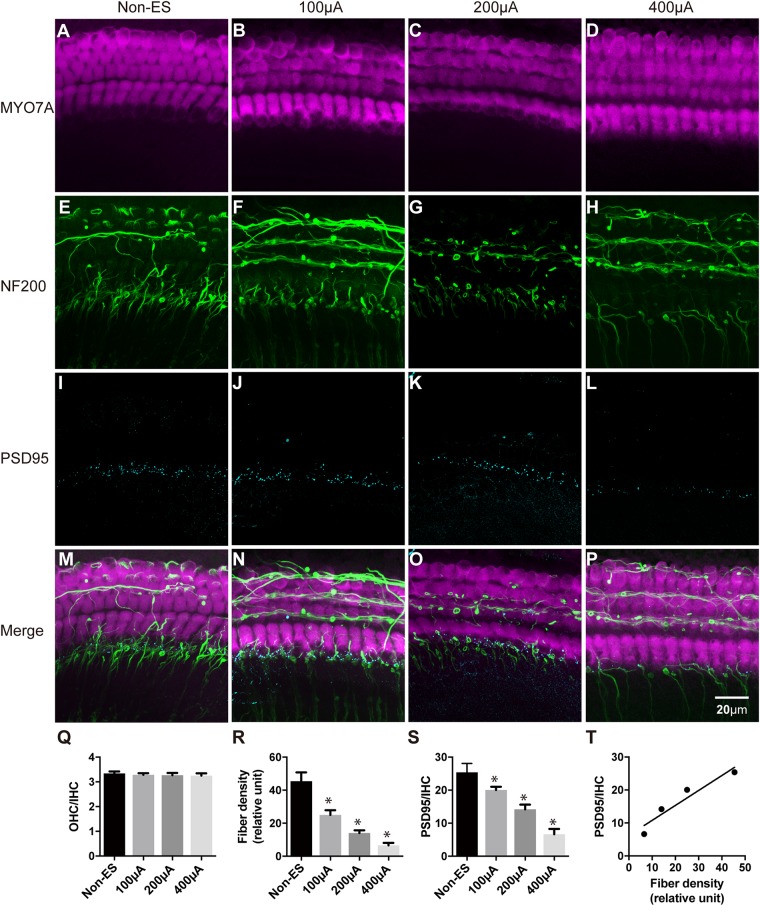
The density of SGN peripheral fibers and the quantity of IHC synapses were synchronously decreased with increasing ES intensity. The quantity and morphology of hair cells (in magenta) were comparable in explants treated with non-ES, 100 μA ES, 200 μA ES or 400 μA ES for 48 h (A–D; P = 0.6957, P = 0.5289, P = 0.3364, compared with non-ES in panel Q, one-way ANOVA followed by Dunnett’s multiple comparisons test, the following comparisons in this paper used the same method unless otherwise noted, n = 5 in each group). The density of SGN peripheral fibers (in green) in explants treated with 100, 200, and 400 μA ES for 48 h was significantly less than that in non-ES explants (E–H; ∗ in panel R, P = 0.0001 when compared to non-ES, n = 20 in each group). The PSD95/IHC ratio in explants treated with 100, 200, and 400 μA ES for 48 h was also significantly less than that in non-ES explants (I–L; ∗ in panel S, P = 0.0001 when compared to non-ES, n = 20 in each group). (M–P) The merged images of the upper three images under the same conditions, respectively. (T) There was a significant correlation between the change of SGN peripheral fiber density and the PSD95-punch/IHC ratio with the increase of ES intensity (Pearson test, r = 0.9538, P = 0.0462). Data represent the mean + SEM.